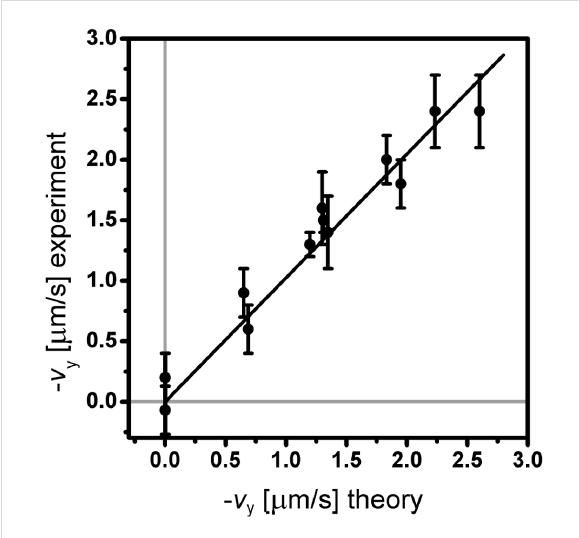
Figure 3: The time- and position-averaged flow velocities that were obtained for a variety of beating parameters are shown versus the theoretically calculated velocity (see data in Table 1). The solid line is a linear fit to the data with the obtained slope coefficient k = 1.02 ± 0.03, showing an excellent agreement between the theory and experi-